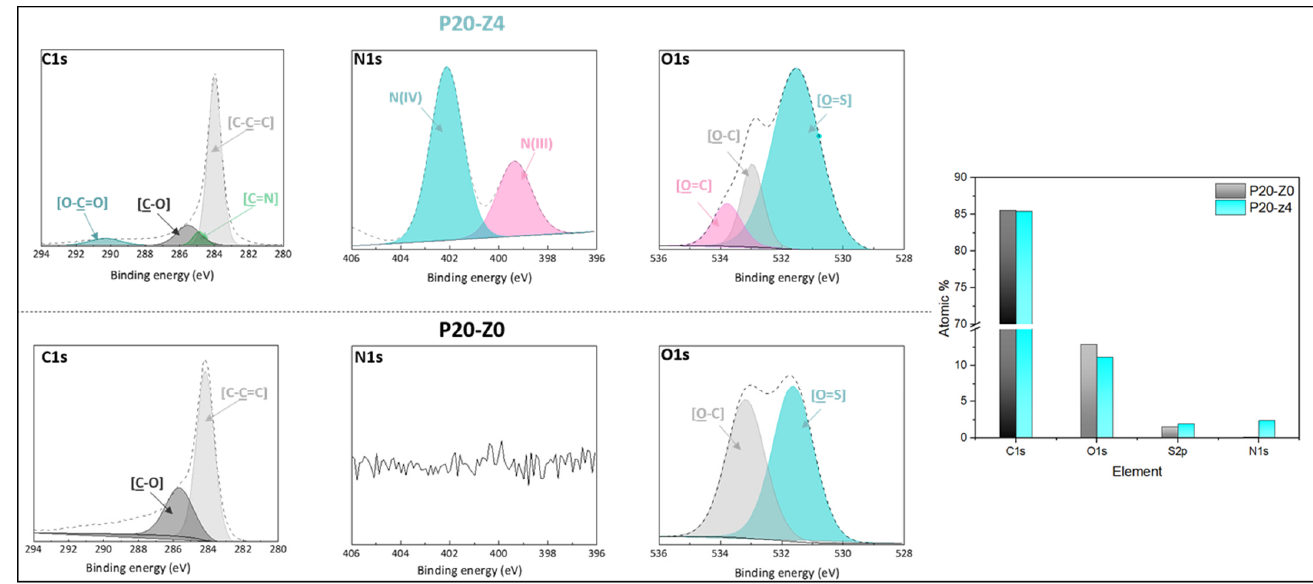
Figure 7. C1s, N1s, and O1s core-level spectra of P20-Z0 and P20-Z4 membranes and their corre- sponding elemental compositions.